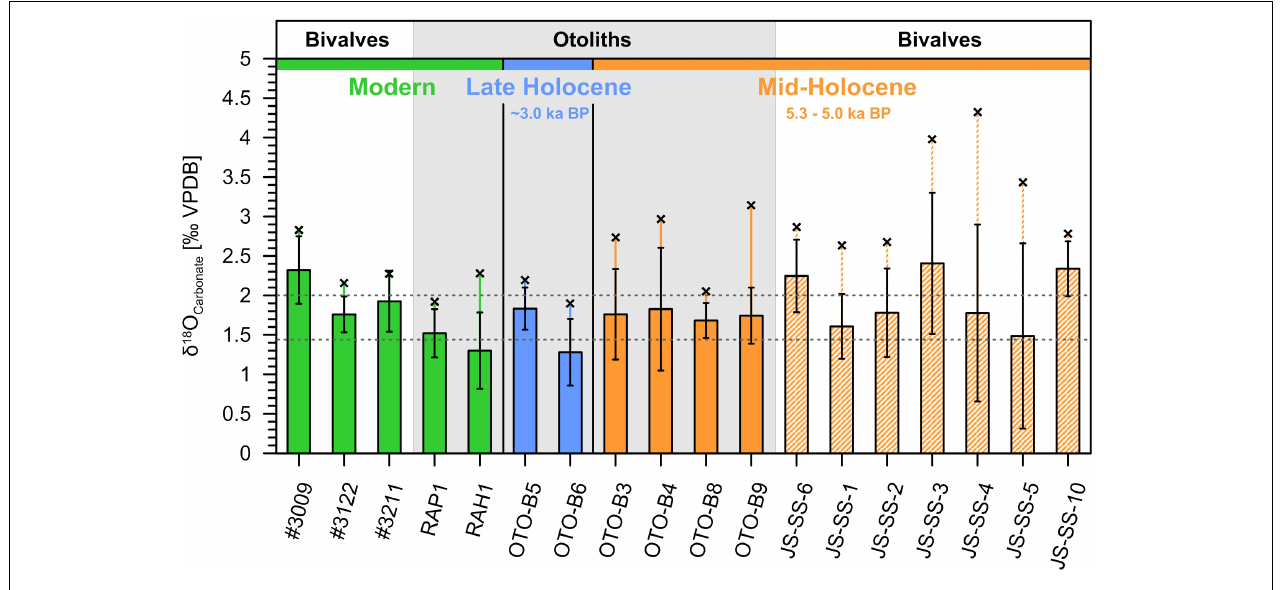
FIGURE 5 | Carbonate δ 18 O seasonal amplitudes and ranges. Bars present the mean seasonal amplitude computed as the difference between the averages of all clearly distinguishable local minima and maxima in the raw ontogenetic δ 18 O records of each sample (see Supplementary Figures S2 , S3 ). Error bars indicate the propagated standard deviation (1SD). The horizontal dashed lines mark the modern mean values for bivalves (ca.